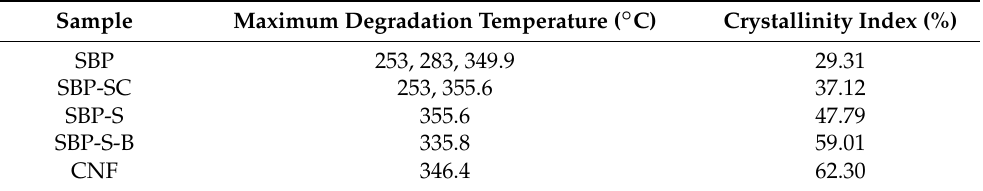
Figure 3. X-ray diffraction (XRD) patterns for SBP, SBP-SC, SBP-S, SBP-S-B, and the CNFs. Table 2. Maximum degradation temperatures and crystallinity indices of samples at different stages. Sample